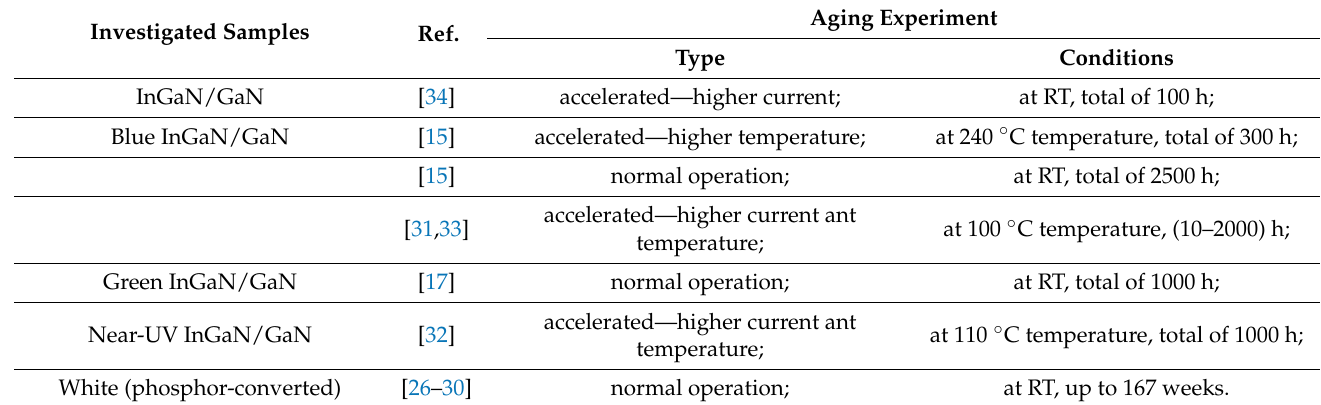
Table 1. Comparison of the different aging experiment types and conditions during which the low-frequency noise measurements of GaN-based LEDs were carried out. All samples contain QWs in their